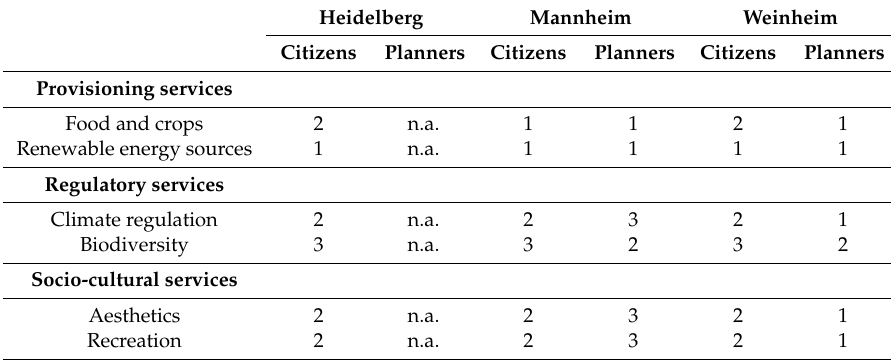
Table 3. Demand matrix for selected ecosystem services for the three study sites by stakeholders. Scale of significance of ecosystem services: 0 = no importance, 1 = rather unimportant, 2 = quite important, 3= very important, n.a. = data not applicable.